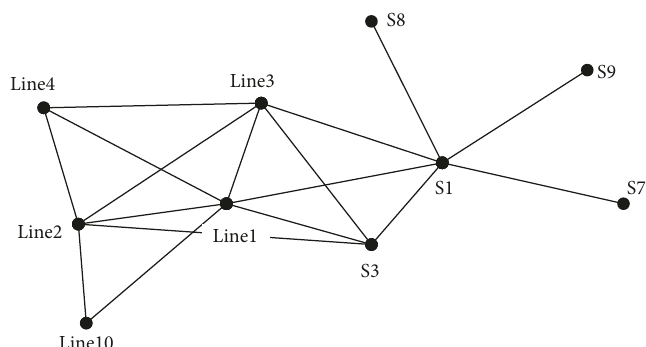
Figure 4: Topology of hyperedge-hyperedge relation in supernetwork of Nanjing